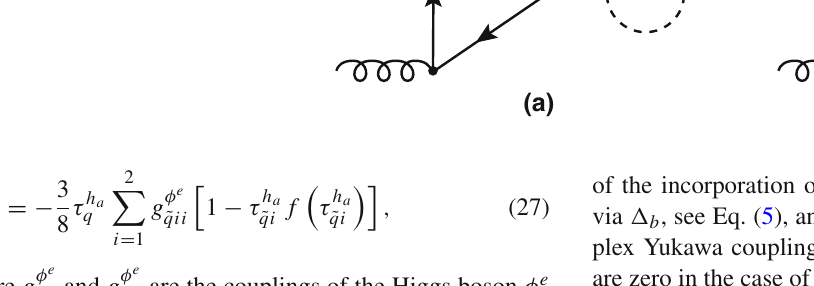
Fig. 1 Feynman diagrams for the LO cross section with a quark and b squark